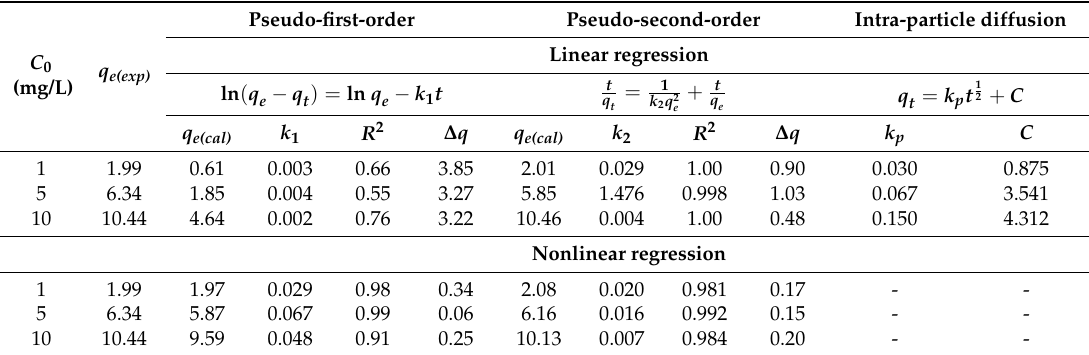
Table 1. Calculated parameters for kinetic models via linear and nonlinear